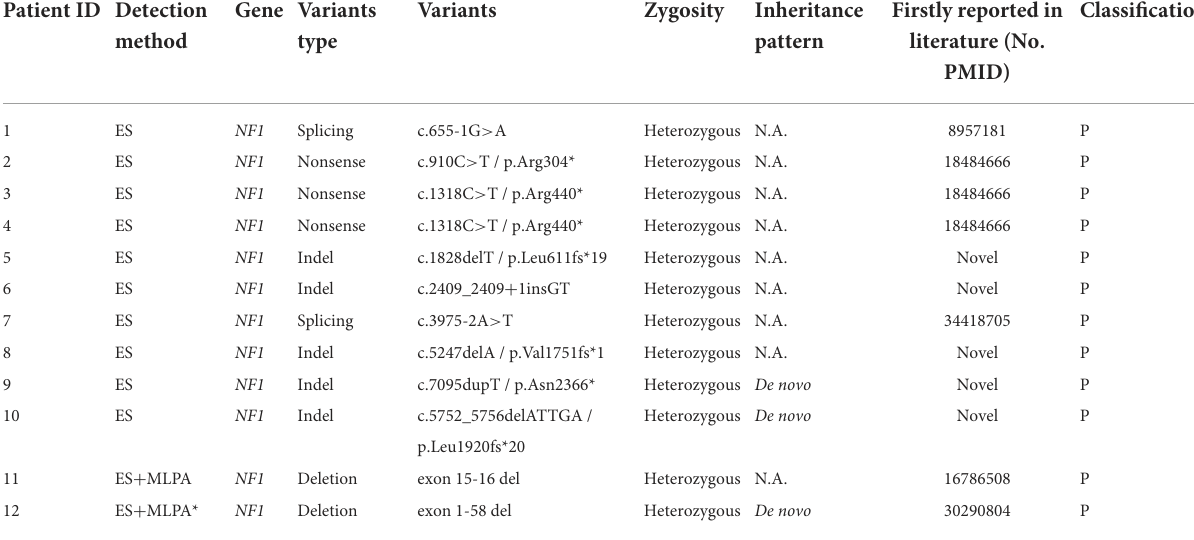
TABLE 2 Variation description of the 12 patients with NF1 associated dystrophic scoliosis. Patient ID Detection